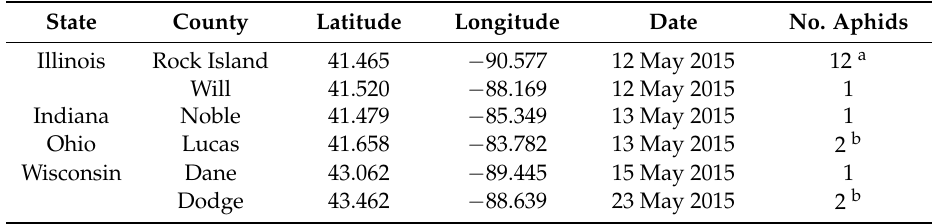
Table 1. Locations of R. cathartica plants from which A. glycines were collected during the spring of